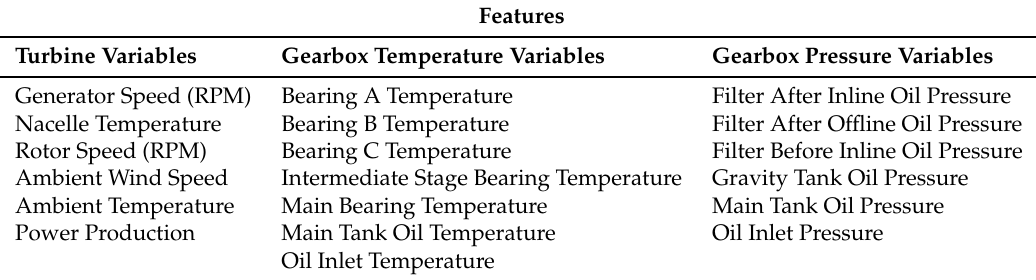
Table 1. List of the features